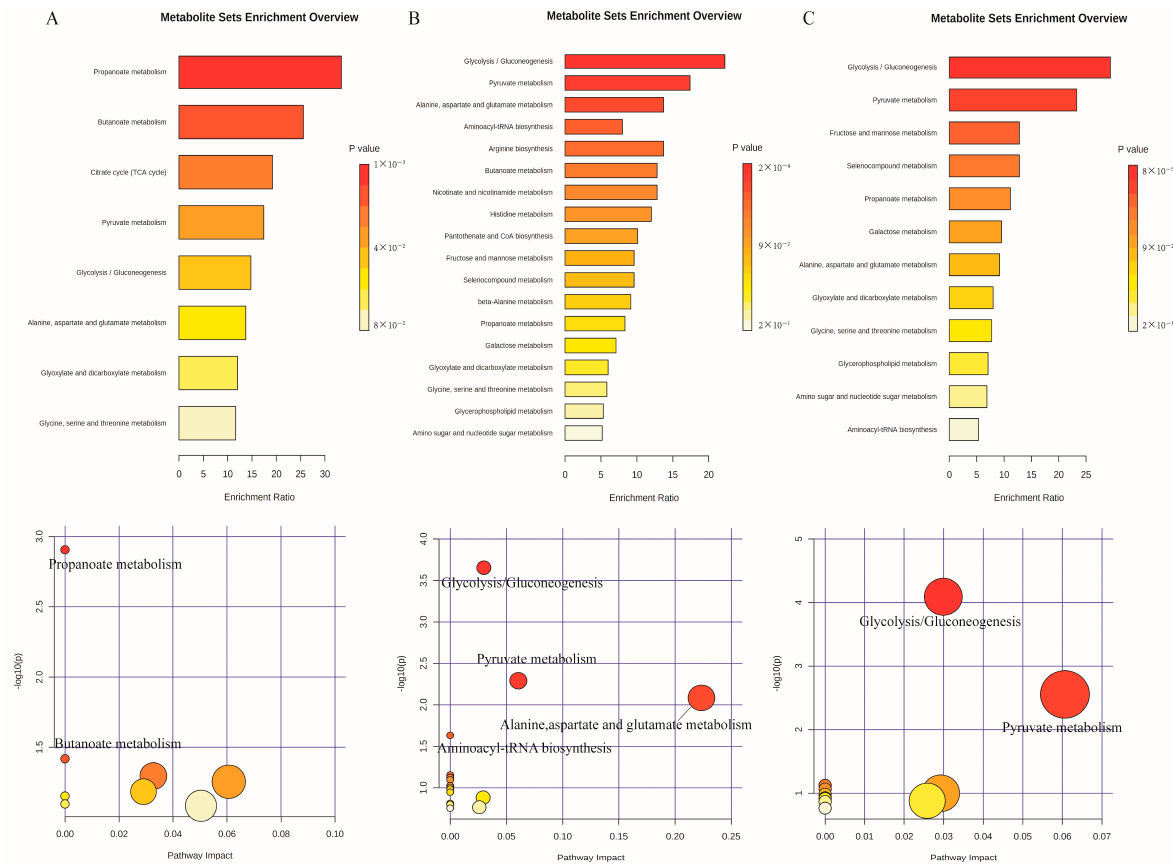
Figure 6. Enrichment analysis and pathway analysis of the main differential metabolites of different DFCs (( A ), ( B ), and ( C ) are DFC1, DFC2, and DFC3 respectively).